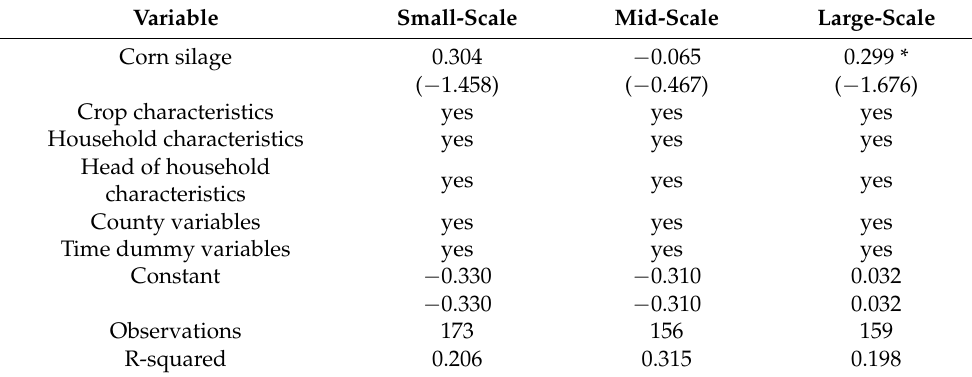
Table 5. Estimated effects of corn silage on farmers’ income at different scales. Variable